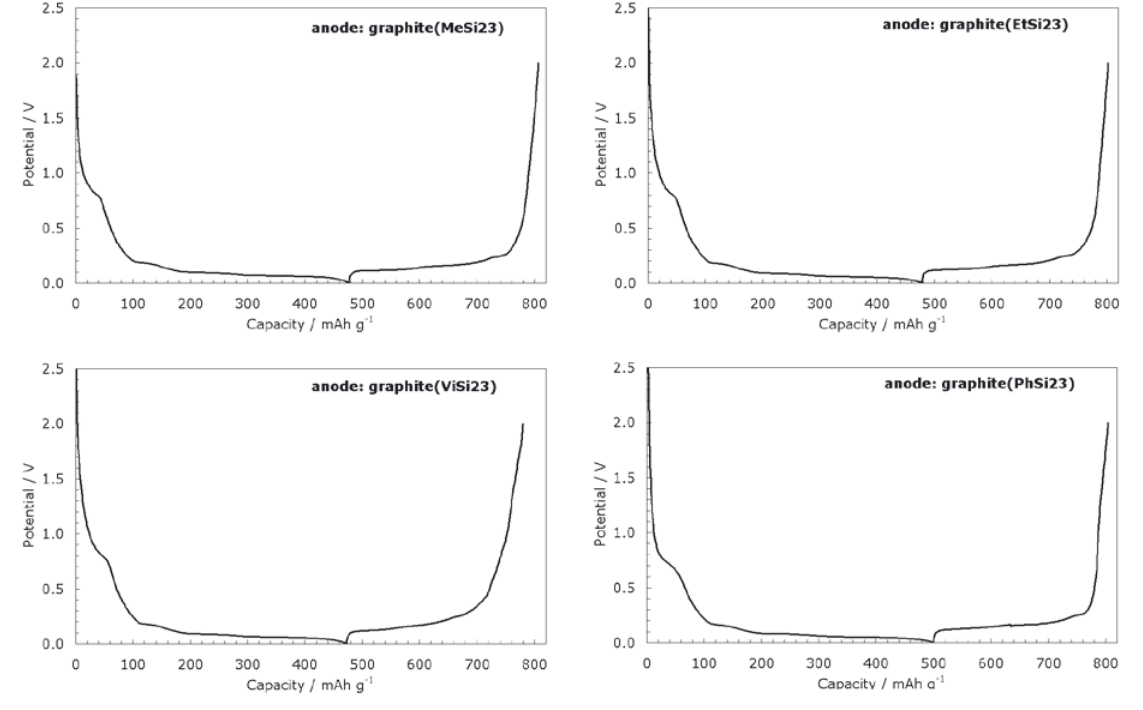
Figure 4. Galvanostatic charge/discharge curves in the first cycles recorded for silane-modified graphite in PC-based